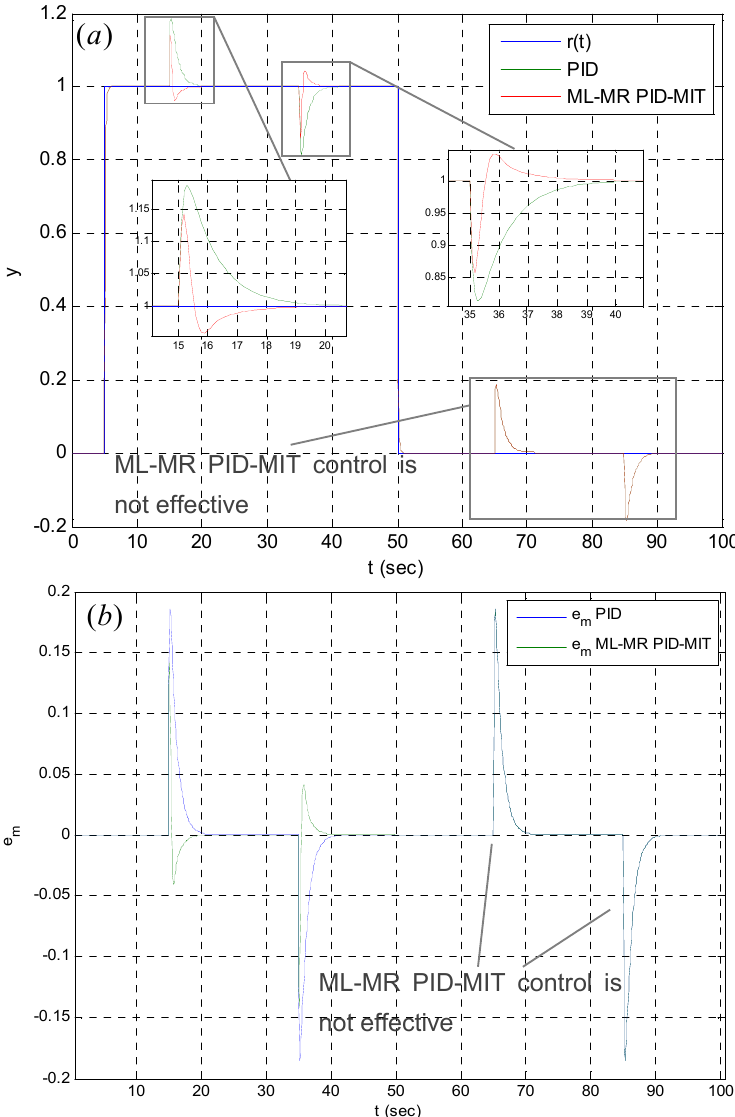
Figure 4. Comparison of disturbance rejection performances of ML-MR PID-MIT control and classical PID control for the cases of r ( t ) = 1 and r ( t ) = 0. ( a ) Step response and ( b ) change of model error